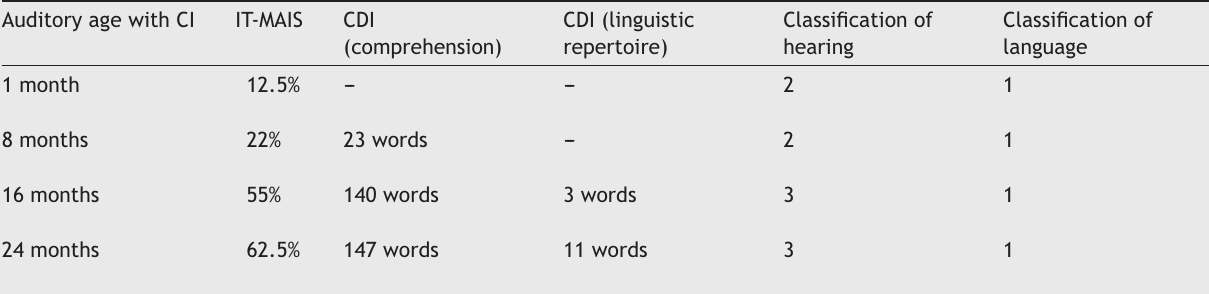
Results of IT-MAIS and CDI tests and classifications of hearing and language of participant C. Auditory age with CI